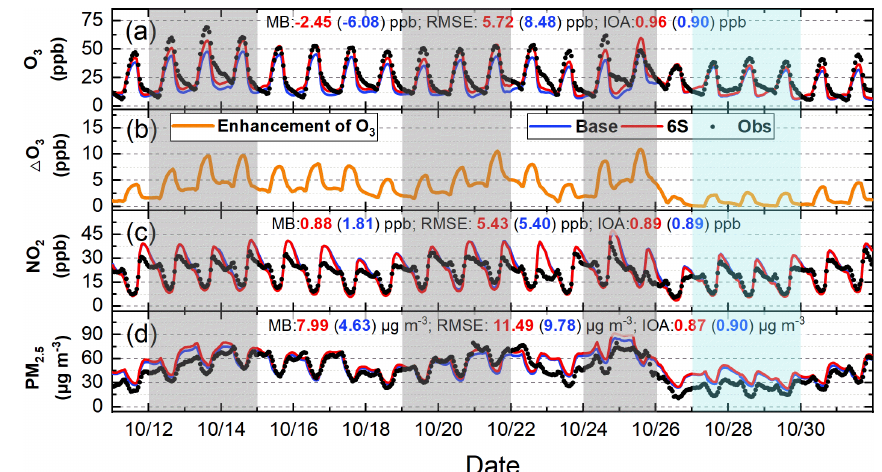
Figure 4. Comparison of 95-site-averaged hourly simulations (Base and 6S cases) and observations of O 3 (a) , NO 2 (c) , PM 2 . 5 (d) , and O 3 enhancements due to the six potential HONO sources (6S minus Base case) (b) in the North China Plain during 11–31 October